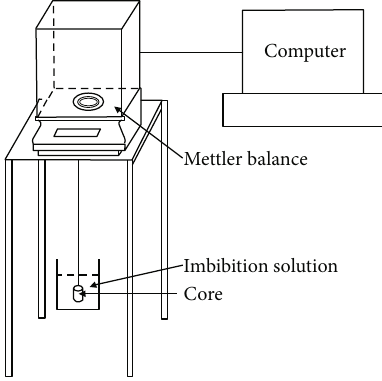
Figure 3: Self-imbibition experimental device.